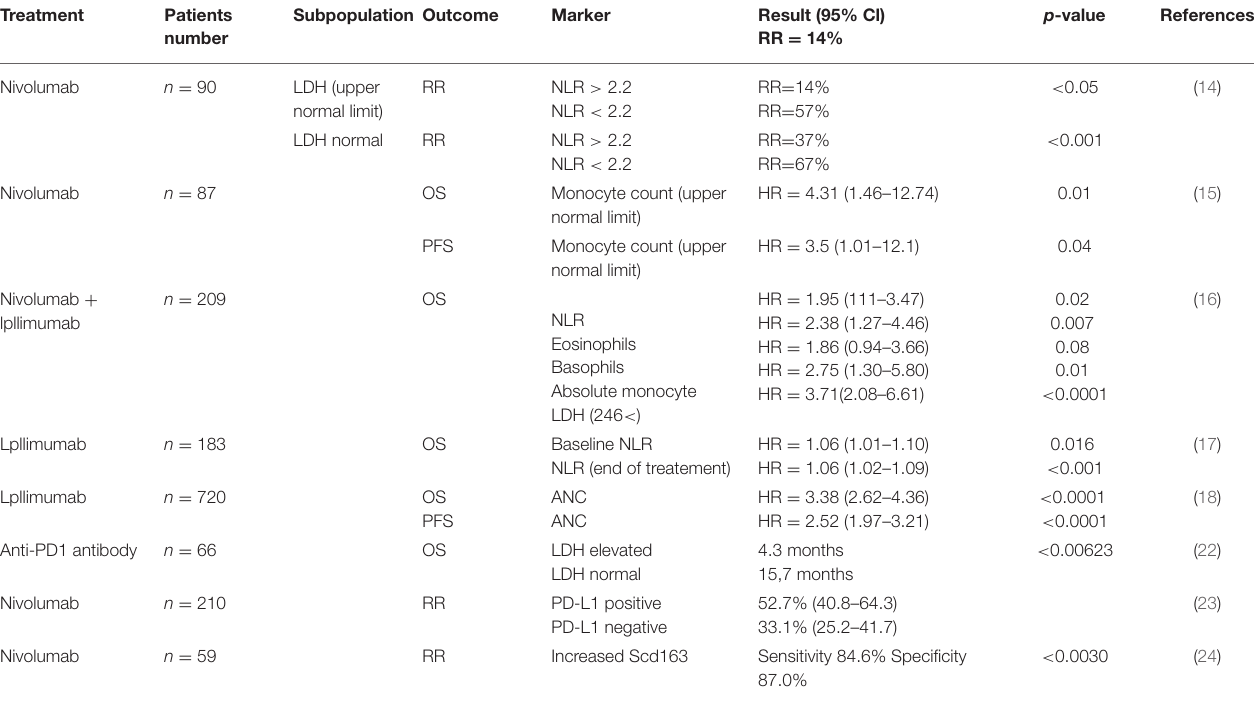
TABLE 2 | Summary of biomarkers and their efficacy.